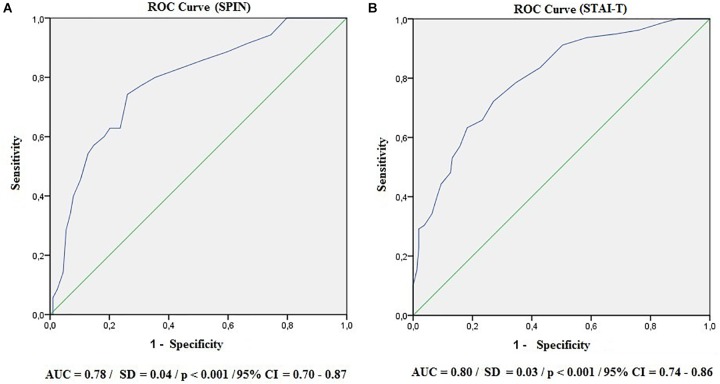
Receiver operating characteristic curves (ROC). AUC, area under the curve; SD, standard deviation; CI, confidence interval. (A) SPIN; (B) STAI-T.